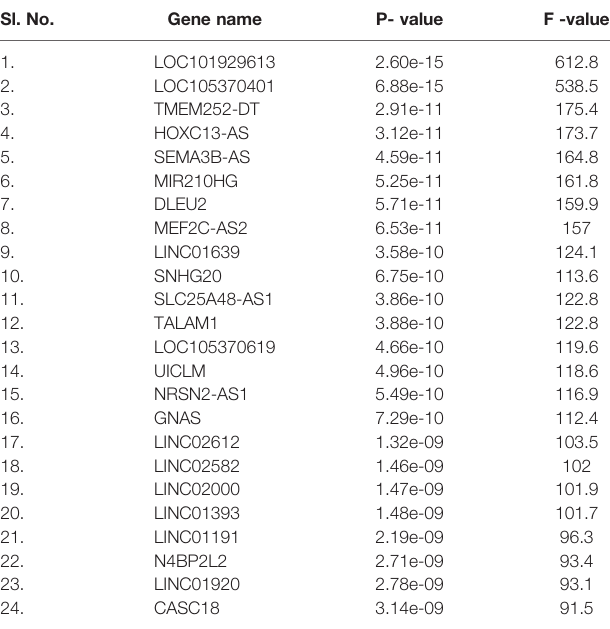
TABLE 4 | Signi fi cantly upregulated lncRNA genes from DEGs between three experimental human groups of our dataset. Sl. No.